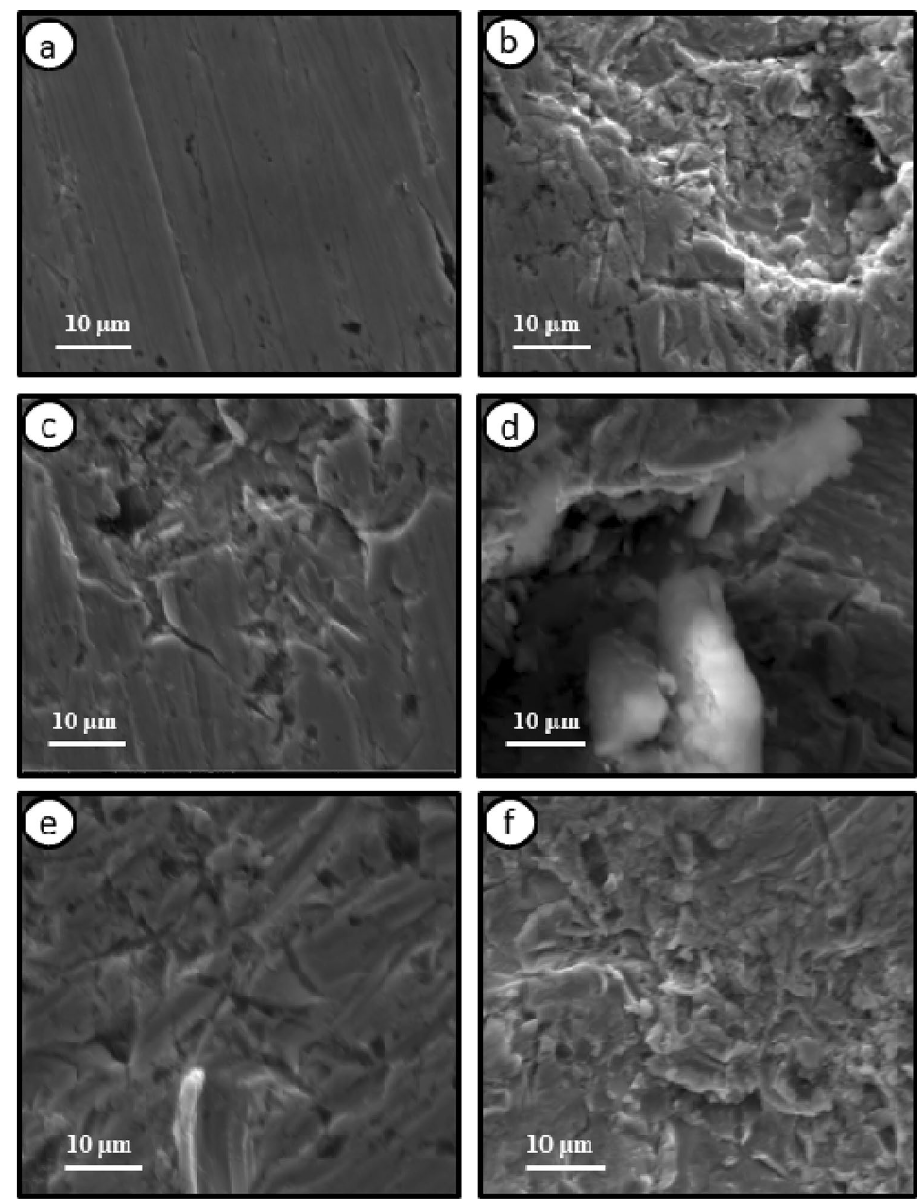
Figure 10. SEM images of Mo surface ( a ) mechanically polished and after 2 h of immersion in ( b ) 3.0 M H 3 PO 4 solution, ( c ) 13 M H 3 PO 4 , ( d ) 3.0 M H 3 PO 4 solution comprising 1.0 M Cl − , ( e ) 3.0 M H 3 PO 4 solution comprising 1.0 M Cl − and 0.5 mM Streptomycin and ( f ) 3.0 M H 3 PO 4 solution comprising 1.0 M Cl − and 10 mM